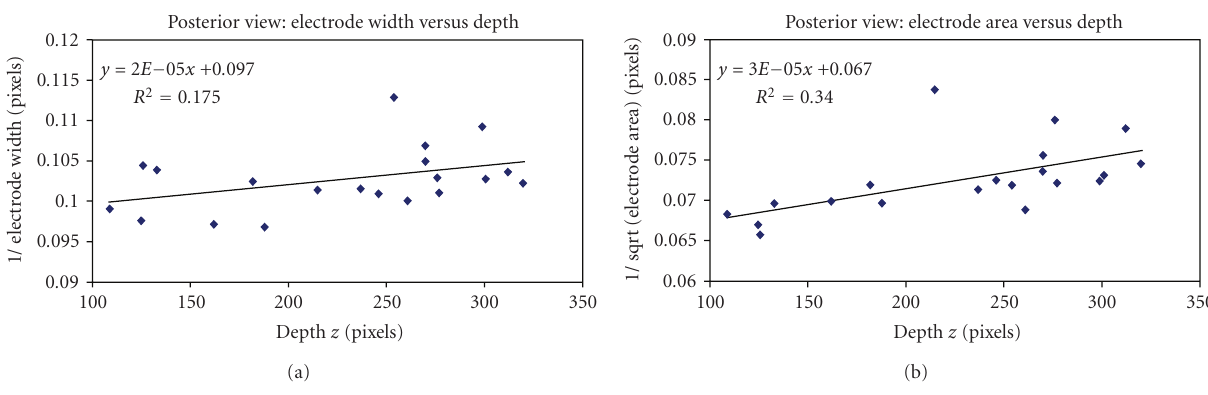
Figure 12: (a) Inverse of the projection width w versus depth z . (b) Inverse of the projection area A versus depth z . The area calculation yields statistically significant result when compared to width